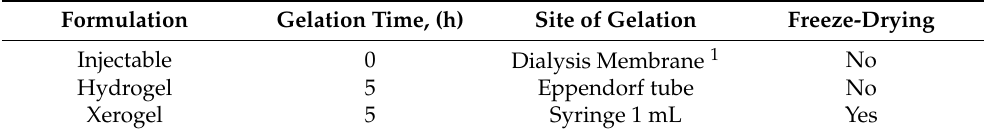
Table 1. Risperidone formulations. Formulation Gelation Time, (h) Site of Gelation Freeze-Drying Injectable 0 Dialysis Membrane 1 No Hydrogel 5 Eppendorf tube